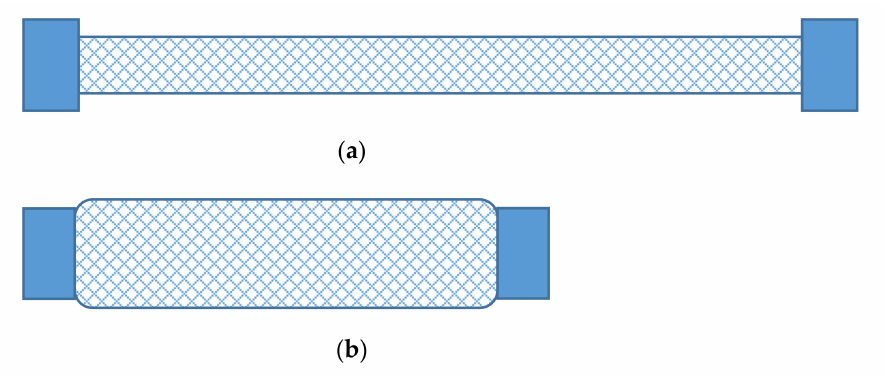
Figure 2. Actuation concept of pneumatic artificial muscles: ( a ) initial state; ( b ) air pressured